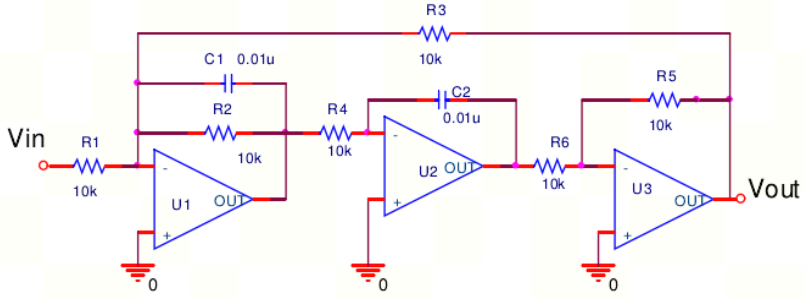
Figure 7. The Tow–Thomas Figure 7. The Tow – Thomas filter.